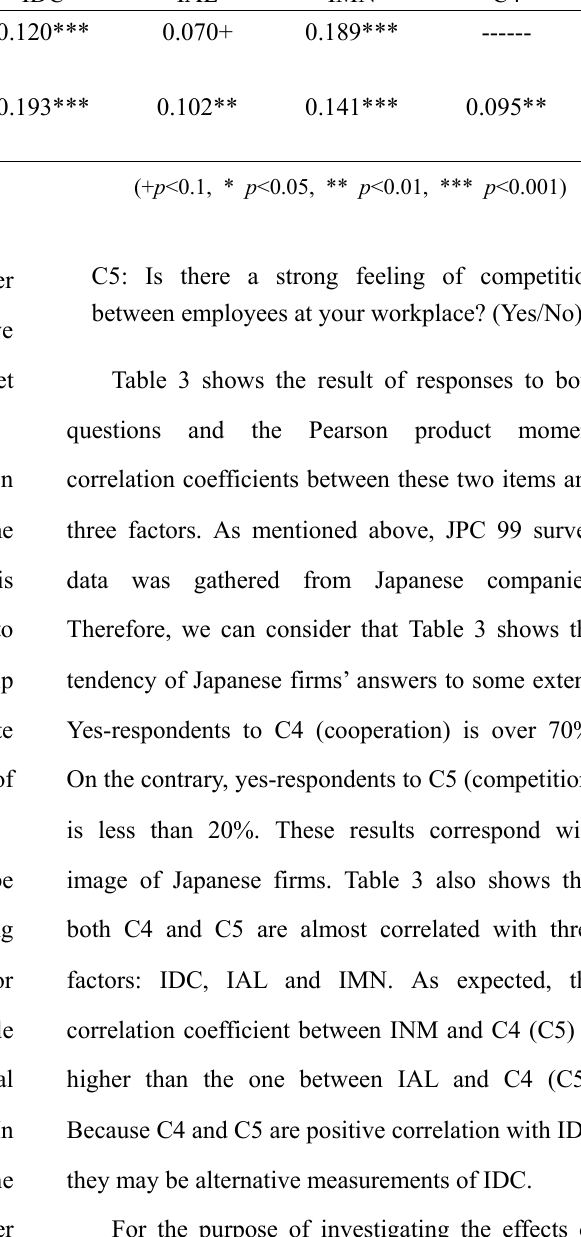
Table 3. The Result of Response to C4 and C5 and Their Coefficients Response Correlation